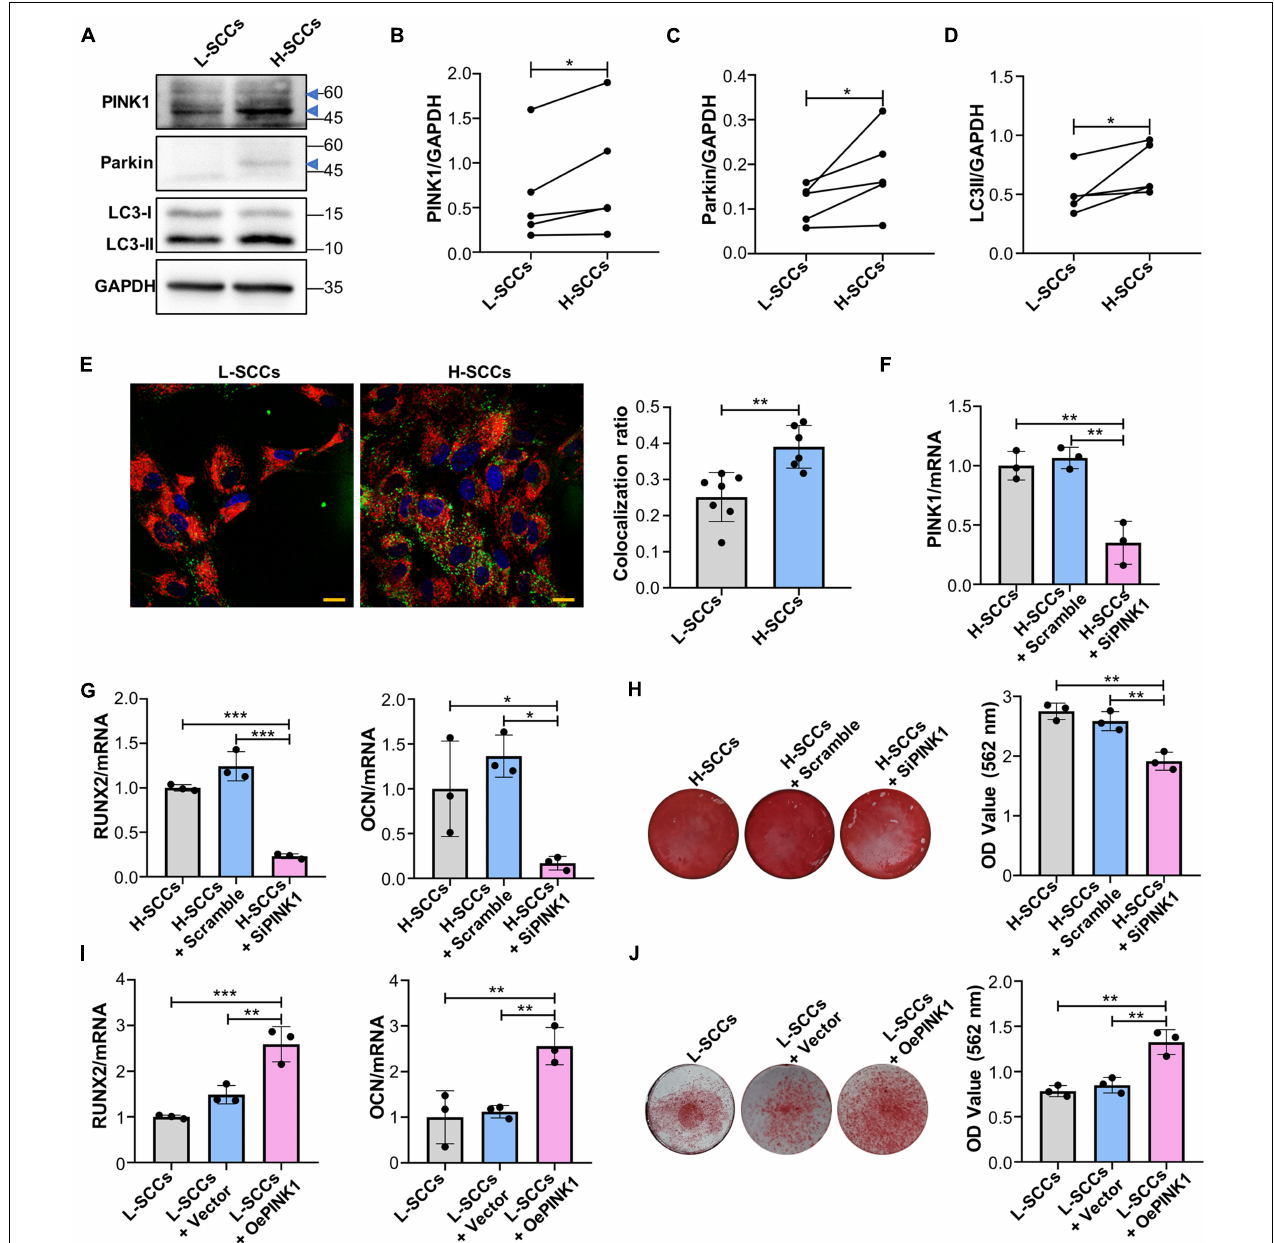
FIGURE 4 | PINK1/Parkin-mediated mitophagy regulated the osteogenic differentiation of SCCs in vitro . (A–D) Proteins associated with PINK1/Parkin-mediated mitophagy in H-SCCs and L-SCCs were tested by western blot and quantified using ImageJ ( n = 5). (E) The colocalization of mitochondria and lysosomes in H-SCCs and L-SCCs was tested by fluorescence microscopy ( n = 7 and 6, respectively). Red, mitochondria; green, lysosomes; blue, nucleus. (F) PINK1 mRNA expression levels in the H-SCCs or H-SCCs transfected with scrambled siRNA or PINK1 siRNA were measured by RT-qPCR (three independent experiments were performed, with similar results; data are from a single experiment performed in triplicate). (G) The expression levels of the osteogenic differentiation-related genes in the H-SCCs or H-SCCs transfected with scrambled siRNA or PINK1 siRNA were measured by RT-qPCR after 7 days of osteogenic induction (three independent experiments were performed, with similar results; data are from a single experiment performed in triplicate). (H) The formation of mineralization nodules in the H-SCCs or H-SCCs transfected with scrambled siRNA or PINK1 siRNA was tested by Alizarin red staining after 28 days of osteogenic induction ( n = 3). (I) The expression levels of osteogenic differentiation-related genes in PINK1-overexpressing L-SCCs were determined by RT-qPCR ( n = 3). (J) Mineralized nodule formation in PINK1-overexpressing L-SCCs was tested by Alizarin red staining ( n = 3). TCs, target cells; L-Exo, exosomes secreted by L-SCCs; H-Exo, exosomes secreted by H-SCCs; H-SCCs + scramble, H-SCCs transfected with scrambled siRNA; H-SCCs + siPINK1, H-SCCs transfected with PINK1 siRNA; L-SCCs + vector, L-SCCs transfected with empty vector; L-SCCs + oePINK1, L-SCCs transfected with a PINK1 overexpression plasmid; the blue triangle represents the expected band for PINK1 or Parkin. Scale bar, 20 µ m. * P < 0.05; ** P < 0.01; *** P < 0.001.